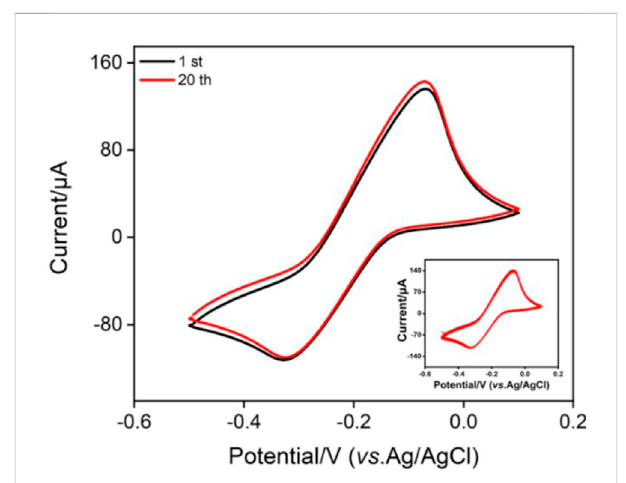
FIGURE 4 CV curves obtained on MB@bp-SNA/ITO in PBS (0.01 M, pH = 7.4). The inset is the CV curves obtained in successive